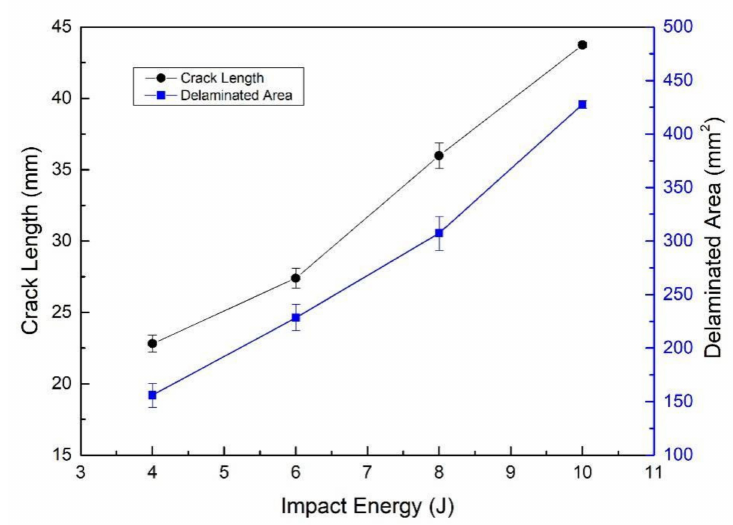
Figure 9. Impact delamination